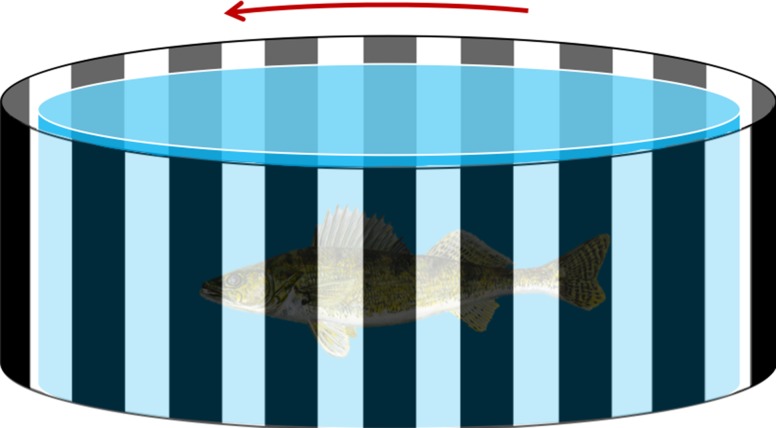
The optomotor apparatus consists of a cylindrical tank surrounded by a rotating screen which is situated approximately 2 cm from the edge of the tank. The screen has 3 cm repeating black stripe pattern for contrast. Fish will follow the black and white rotating stimulus until the turbidity level is such that the fish can no longer distinguish the contrast between the black stimulus and white background. Walleye were tested in a 40-cm diameter tank while Emerald Shiner were tested in an 18-cm diameter tank.